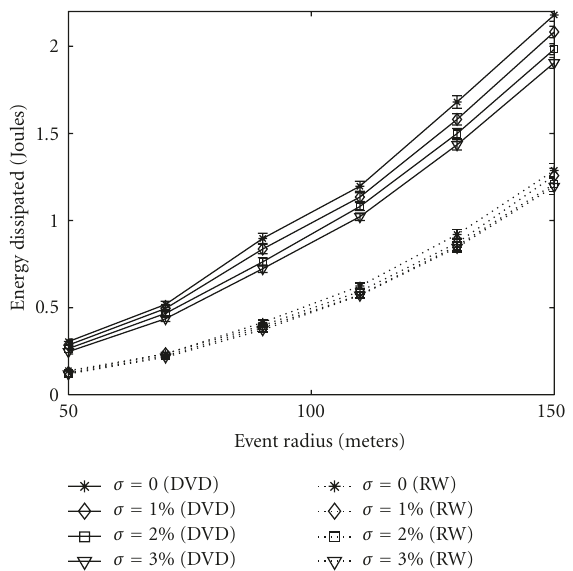
Figure 22: Sensitivity of Energy dissipated in the network for DVD and RW.